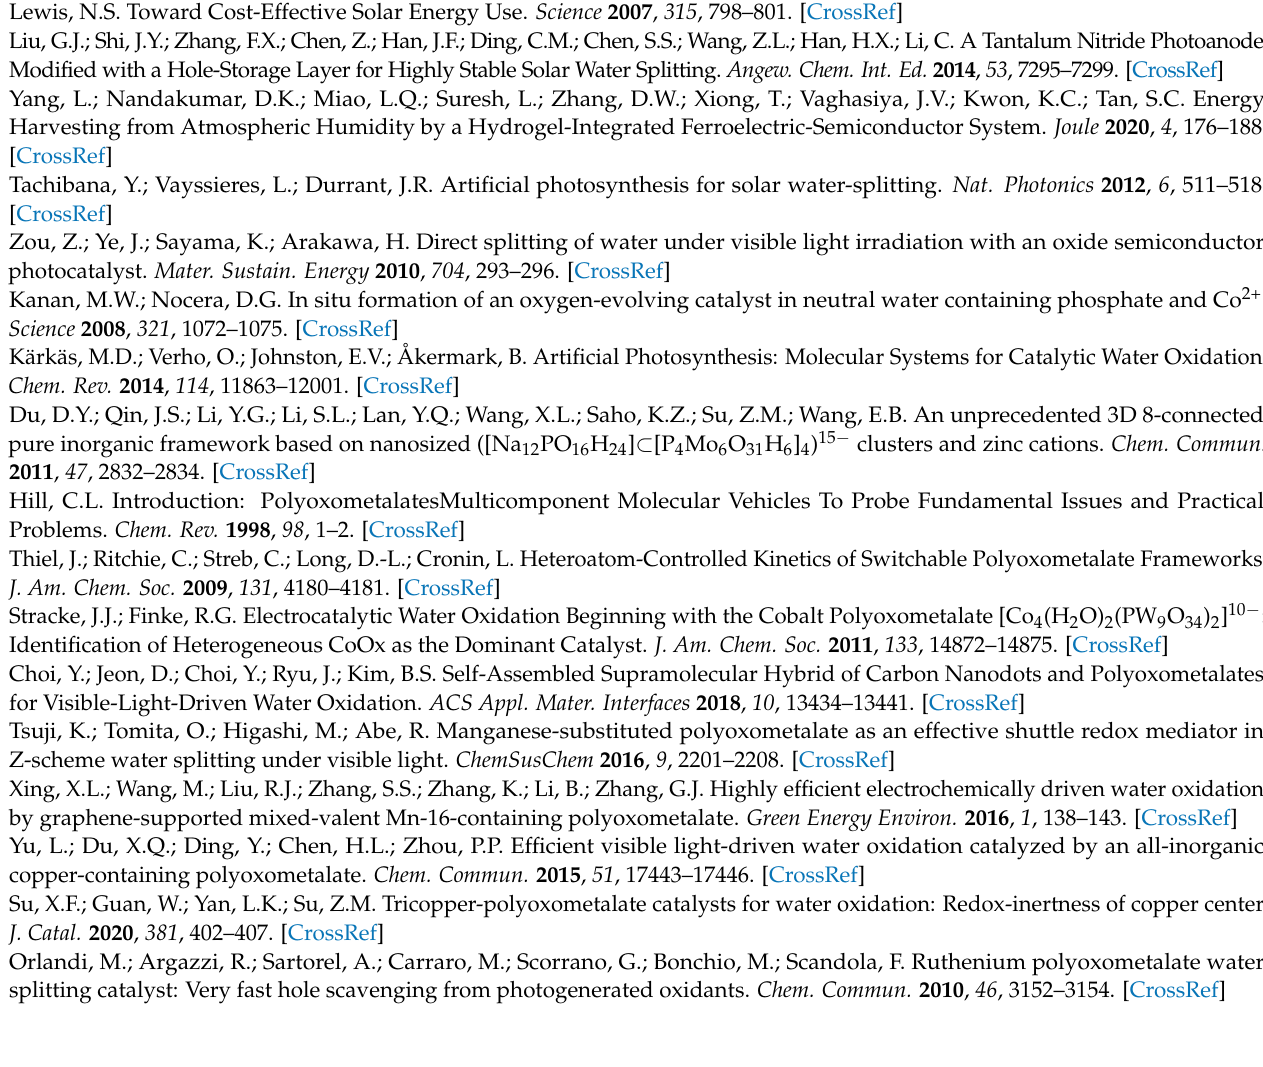
films; Figure S4: XPS spectra of two films; Figure S5: CVs of the film at different scan rates; Figure S6: The relationship of the photogenerated currents vs. the different number of layers; Figure S7: CVs of different conditions; Figure S9: CVs of two films with different cycles; Table S1: Comparison of